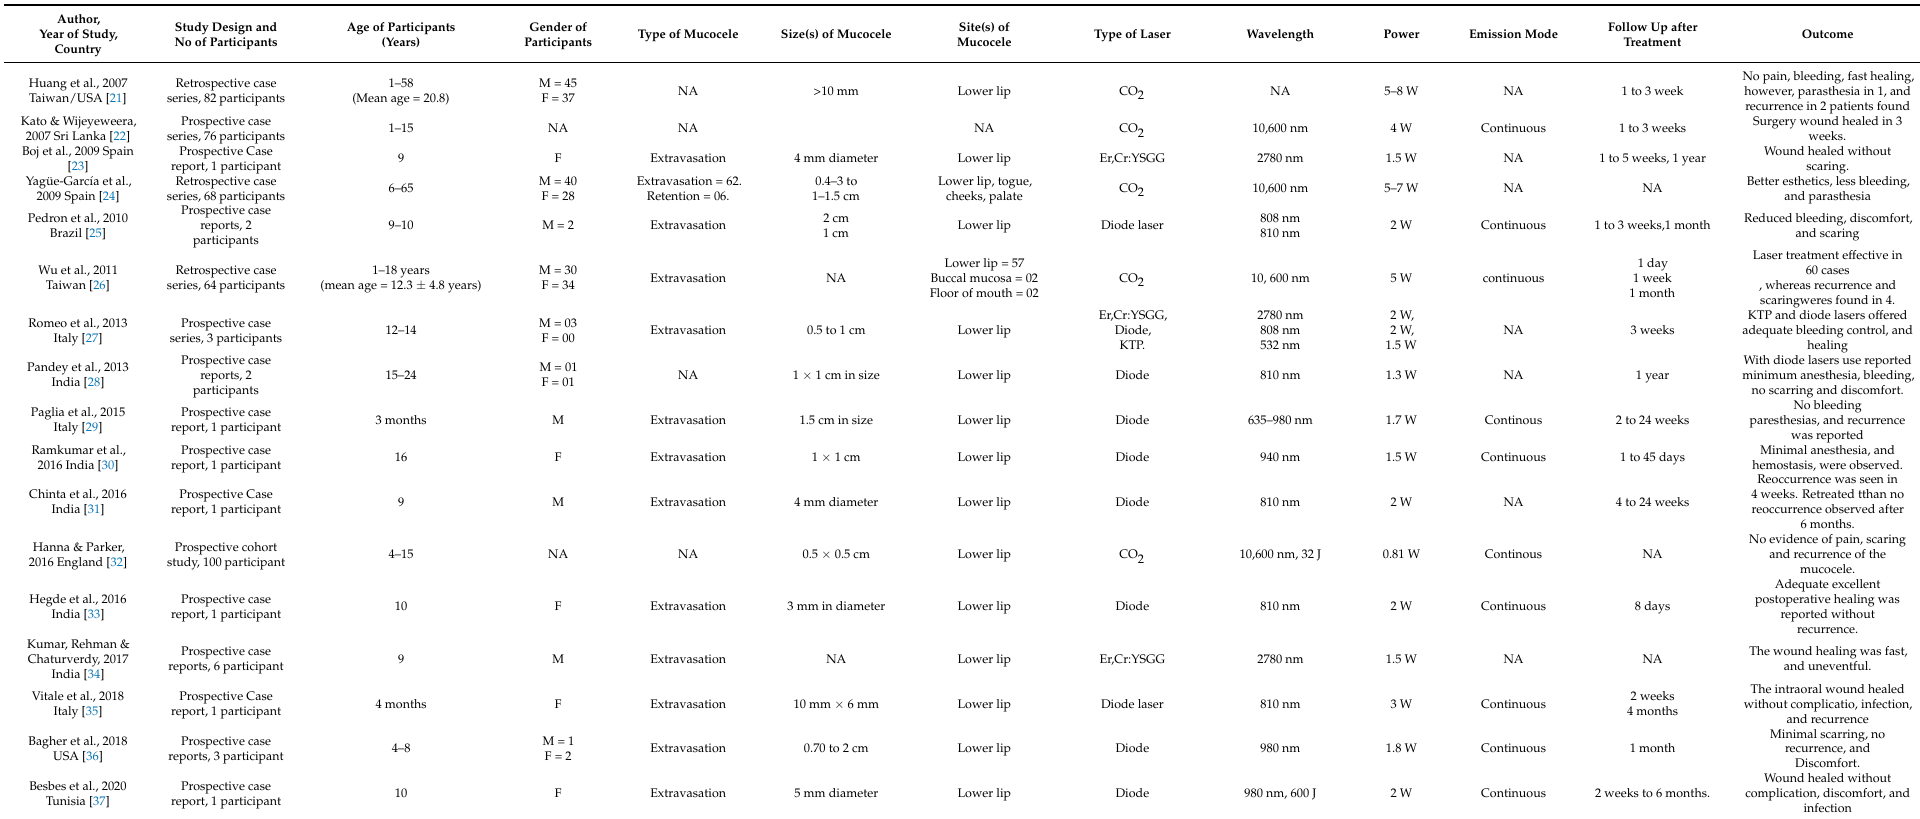
Table 2. General characteristics and outcomes of the included